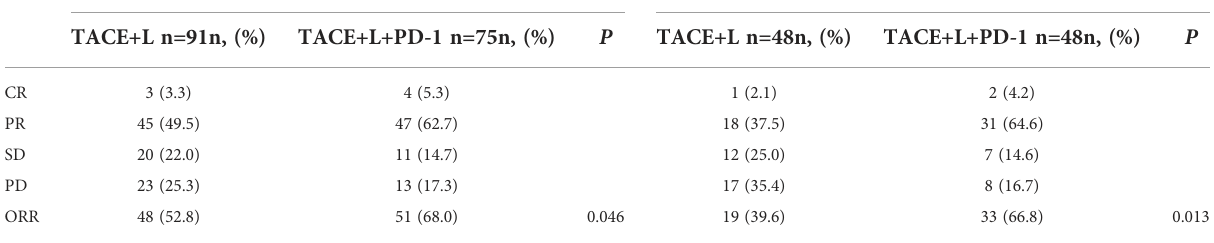
TABLE 2 Tumor response before and after PSM.